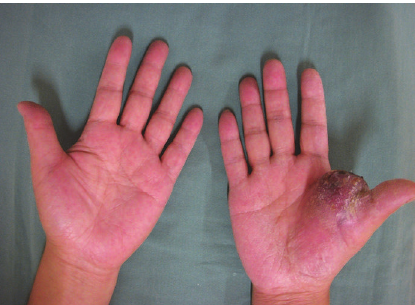
Figure 1: Soft tissue mass in the right hand. The mass was located in the first intercarpal space, with the overlying skin showing discoloration.